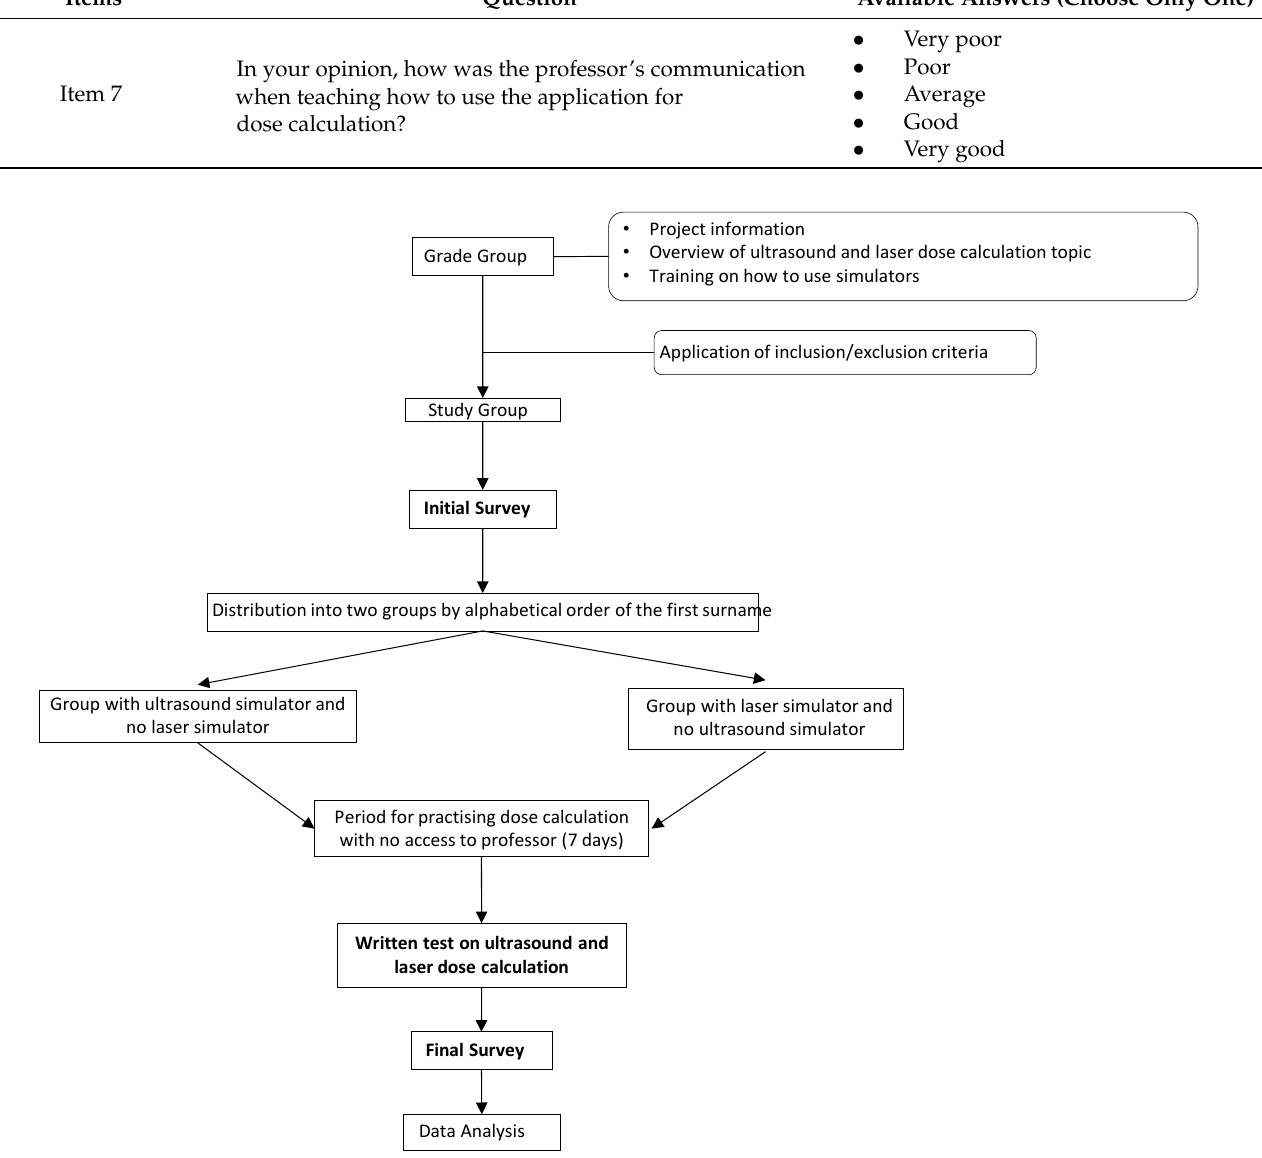
Figure 1. Flowchart depicting the study process. Source: Prepared by authors.